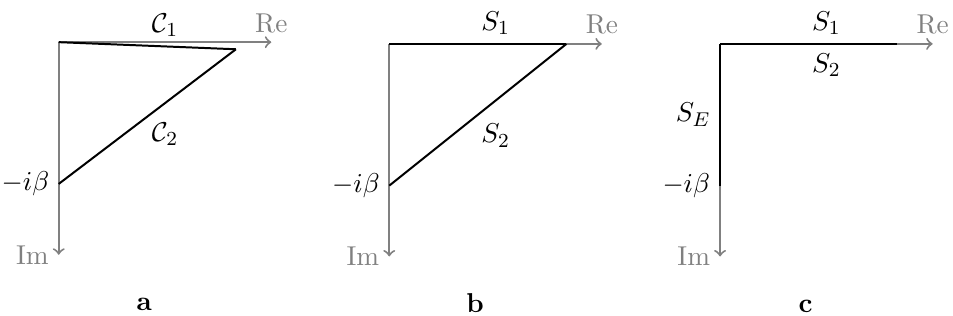
Figure 3 . Three different realizations of the thermal Schwinger-Keldysh contour for a system with temperature T = 1 . The leftmost setting (a) corresponds to the contour adopted e.g. in β ref. [44]. Our first goal is to be able to remove the tilt on the forward contour (b) and ultimately in preparation for the non-equilibrium setting to move both the forward and backward branch very close to the real-time axis (c). We find that the inherent regularization of the implicit solver allows us to realize scenarios (b) and (c) in